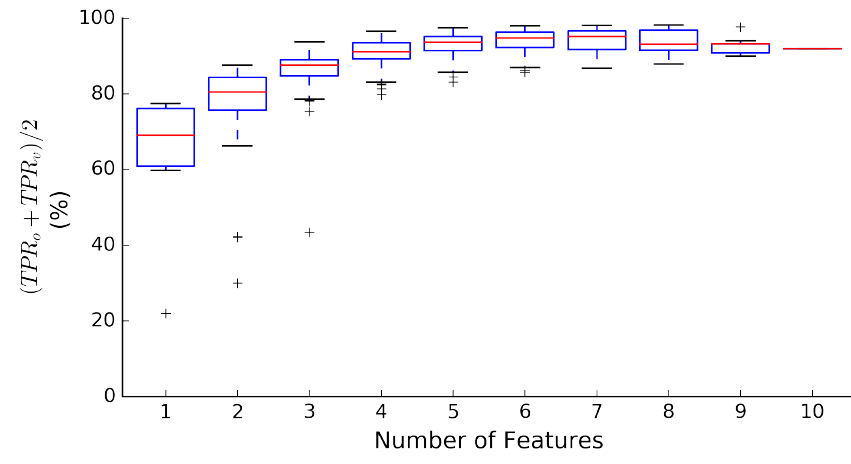
Figure 3. Ranges of classifier performance on a weighted metric that balances overall True Positive Rates on the basis of occurrences and volume. For a given number of features, the highest point in the column indicates the best performance for all feature combinations. Boxes represent the 1st and 3rd quartile of performance and the red line indicates median performance. The whiskers extend to the highest and lowest value beyond the box that is less than or equal to 1.5 times the interquartile range. There is only one possible combination of the 10-feature